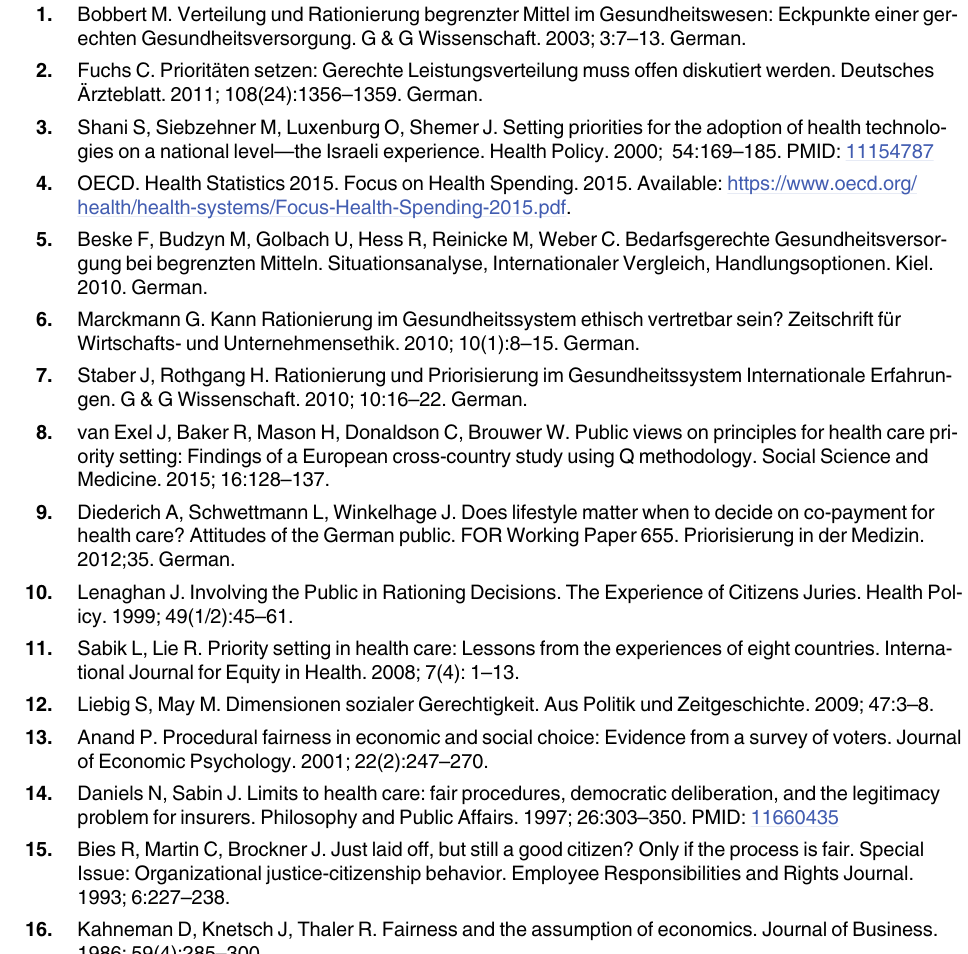
S1 Table. Fixed-Effect logistic regression models: influencing factors on peoples ’ support of smoking habits, age and parenthood of a minor child as priority